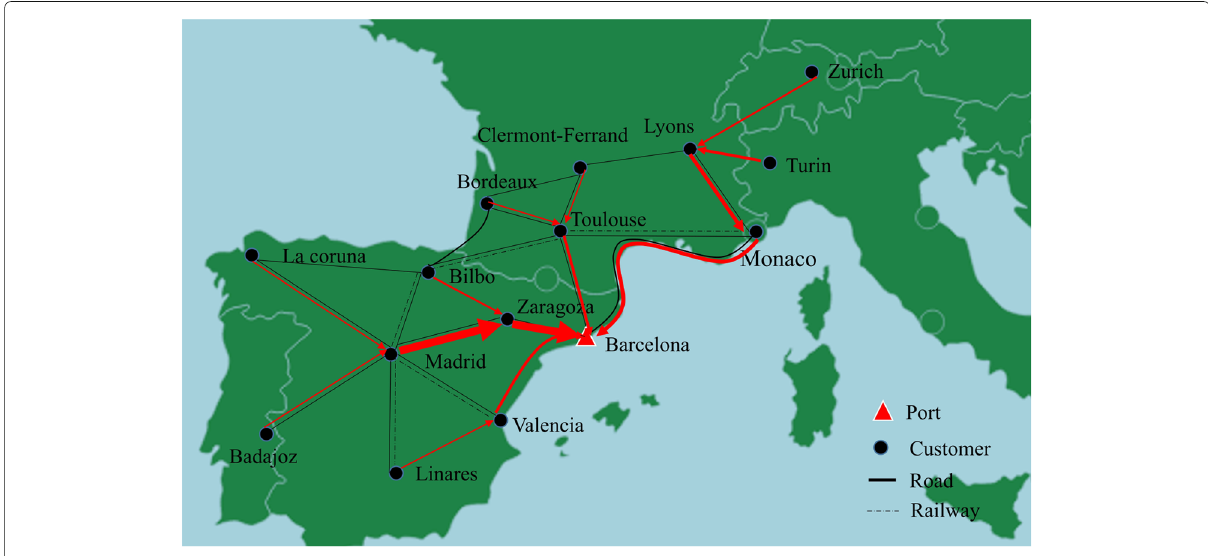
Fig. 12 Transportation of export-full containers